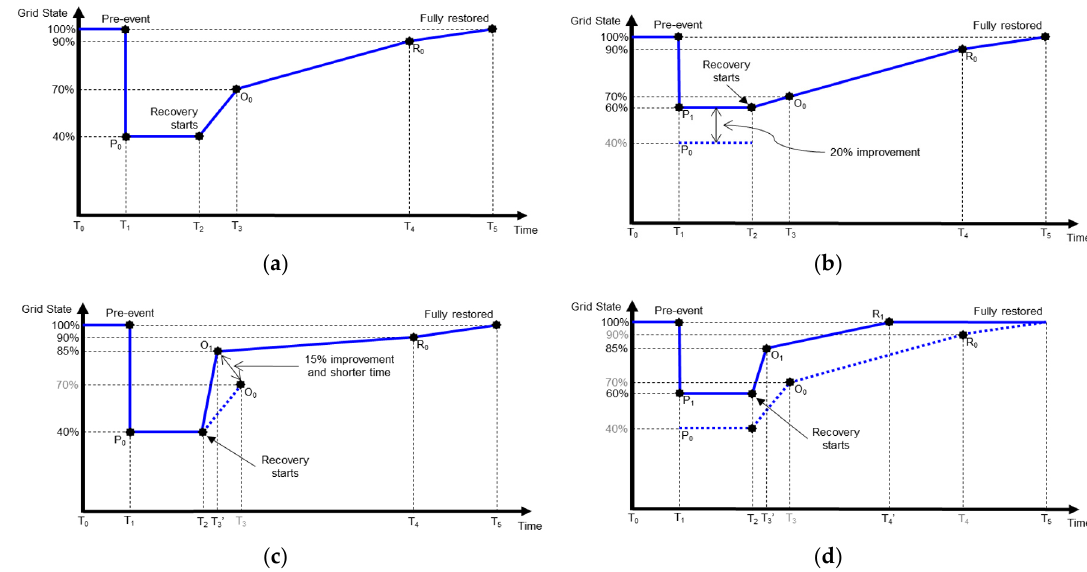
Figure 6. Illustration of grid state transition for different implementation of enhancement strategies. ( a ) Grid state transition before implementation of the enhancement strategies; ( b ) grid state transition with enhancement on the physical durability; ( c ) grid state transition with enhancement on the operational versatility; and ( d ) grid state transition with enhancement on all determinants.